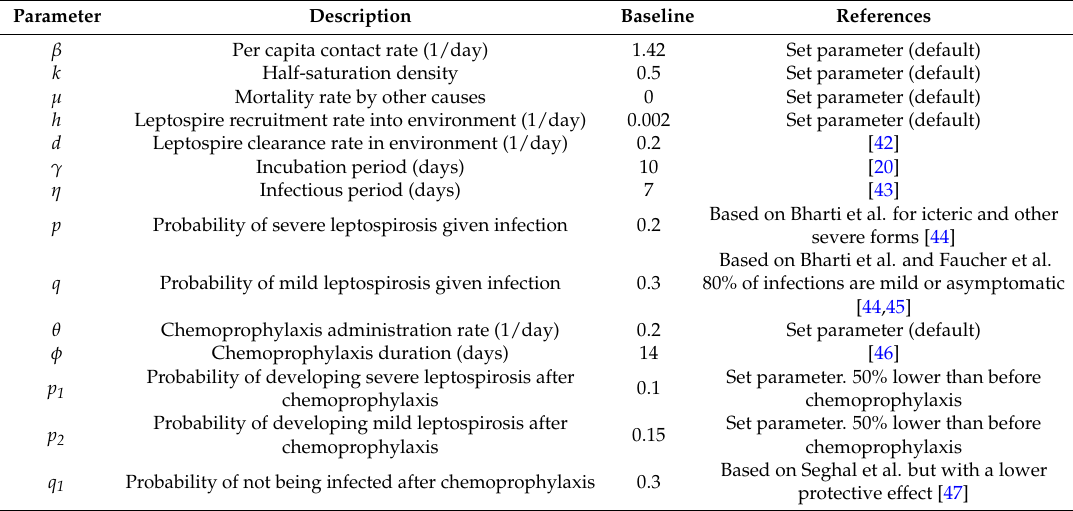
Table 1. Model parameter description and baseline